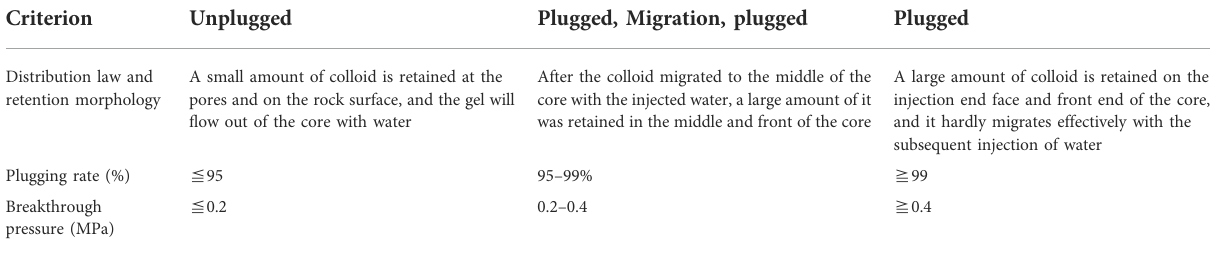
TABLE 7 Judgment criterion for matching between polymer gel pro fi le control agent and reservoir.